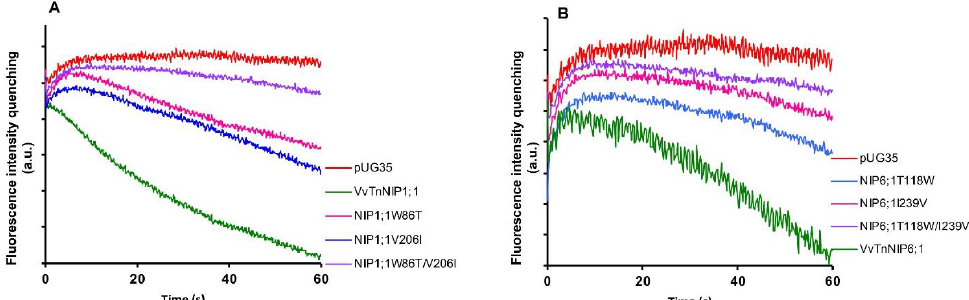
Figure 2. Glycerol permeability of yeast cells transformed with grapevine NIPs and their mutants in H2, H5, H2 / H5 helices. Fluorescence quenching after a hyperosmotic shock applied to yeast cells expressing ( A ) VvTnNIP1;1 and their single mutants W86T, V206I, and double mutant (W86T / V206I). ( B ) VvTnNIP6;1 and their single mutants T118W, I239V, and double mutant (T118W / I239V). Yeast strain with an empty vector (pUG35) was considered as the negative control.